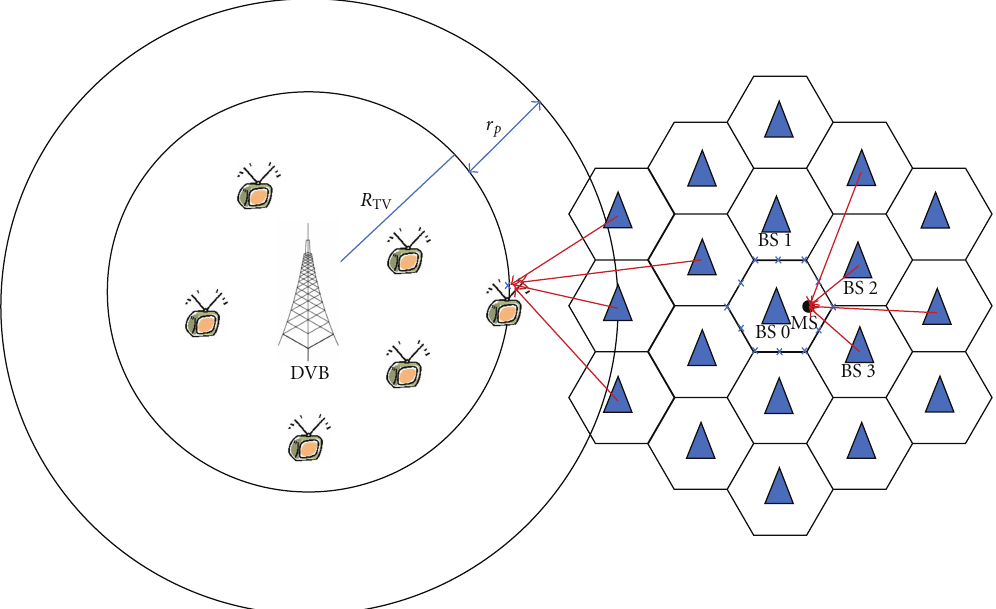
Figure 1: System illustration for single TV transmitter case. The cellular network operates co-channel to the TV transmitter and it is deployed outside of the TV protection area. The aggregate interference has to be controlled at the TV test points and the cellular cell